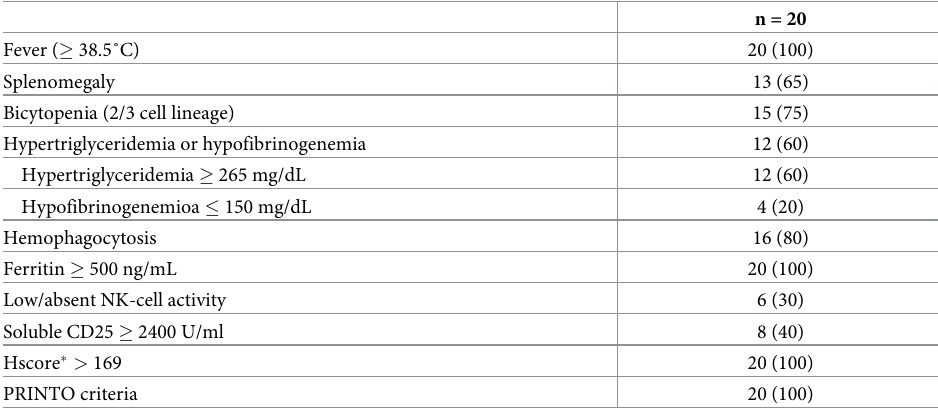
Table 1. Diagnostic criteria fulfilled by the 20 eligible patients in